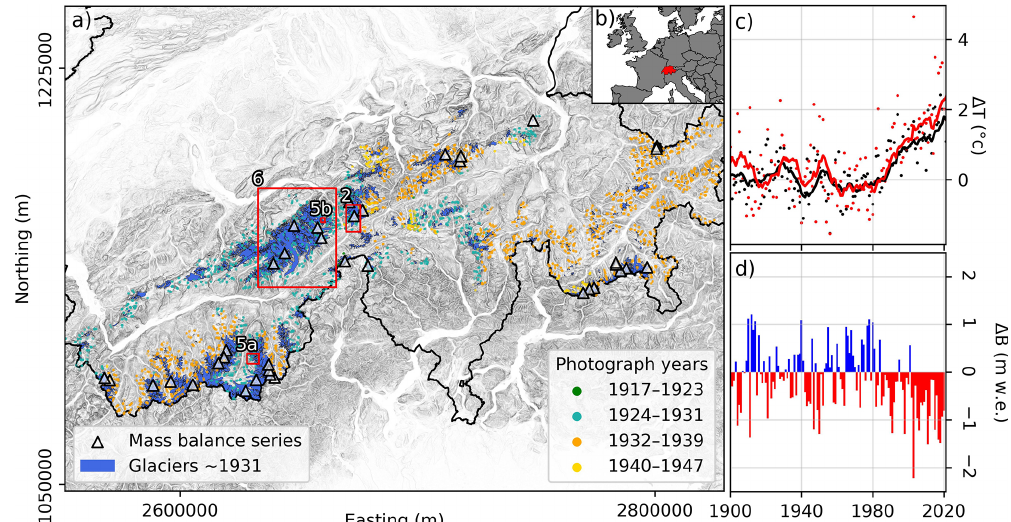
Figure 1. (a) The distribution of Swiss glaciers around 1931 (blue areas). Country borders are outlined in black. The locations of the TerrA photographs used in the study are shown with coloured dots, whose colour indicates the year of acquisition. The red boxes show the bounds of other figures (figure numbers given in white). (b) The location of Switzerland (marked in red) in Europe. (c) Anomalies of mean annual (black) and mean summer (red) air temperature from 1961–1990; 10-year running averages are drawn as lines, and the data are from 14 homogenised stations (MeteoSwiss, 2021). (d) Mean anomalies in annual glacier mass balance compared to 1961–1990. The data are described in Sect. 2.3. Map coordinates are in the Swiss CH1903+/LV95 (EPSG:2056) coordinate system.